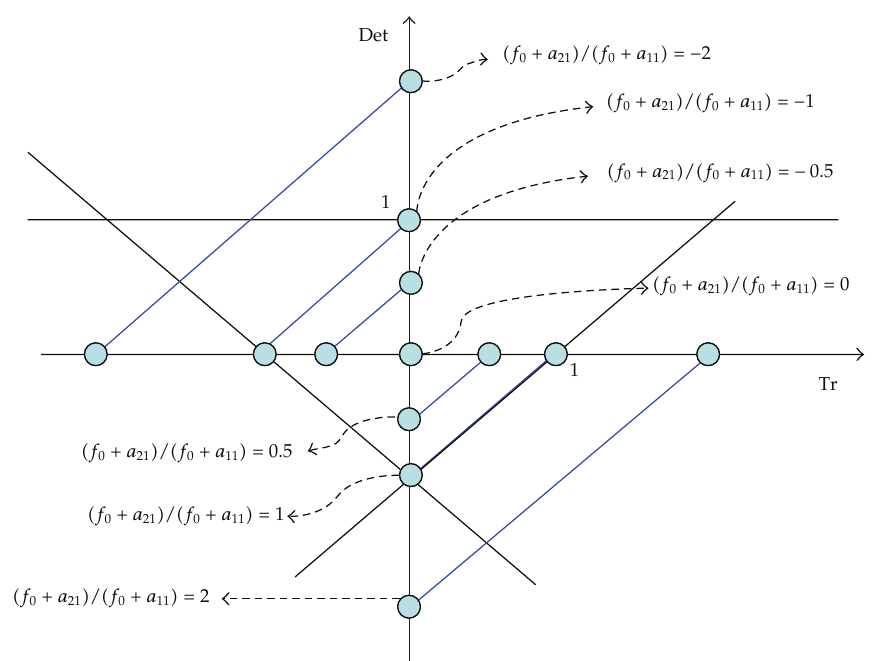
Figure 6: Trace-determinant diagram under the dynamic rule involving expectations—characterization of the stability of p ∗ (cid:3) 1 (cid:4)